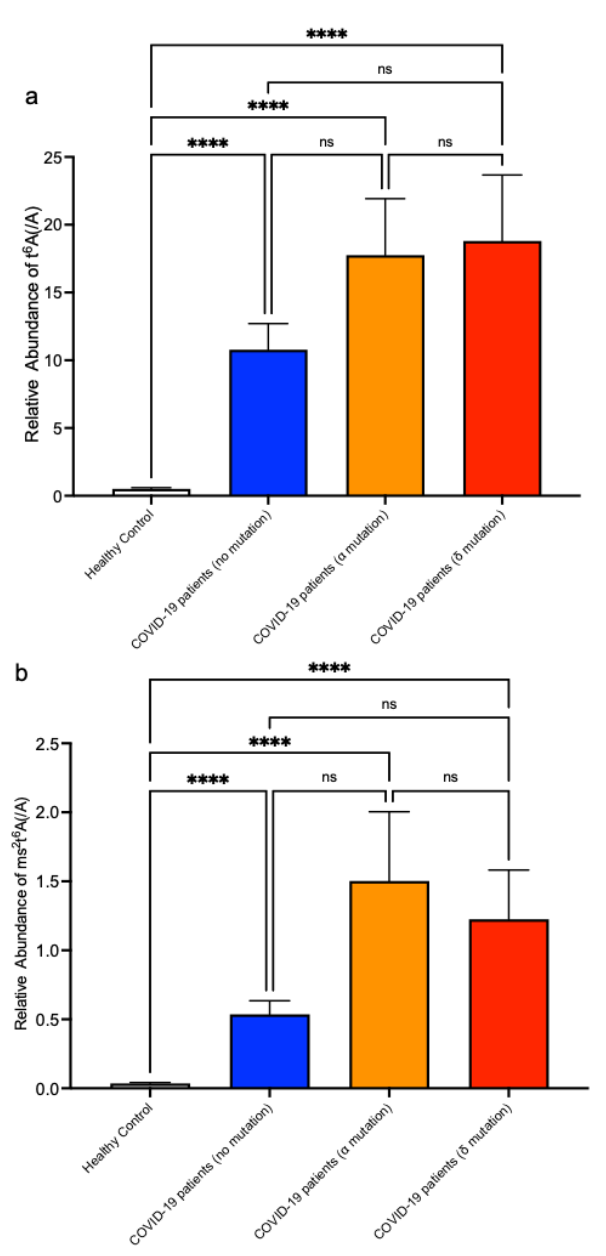
Figure 6. Elevation of t 6 A and ms 2 t 6 A levels in serum of patients infected by different SARS-CoV-2 strains. ( a , b ) Measurements of t 6 A ( a ) and ms 2 t 6 A ( b ) in serum of COVID-19 patients infected with α strain or δ strain compared with healthy volunteers. LC-MS peak areas of t 6 A or ms 2 t 6 A divided by LC-MS peak areas of adenosine are shown. **** p < 0.0001 by Kruskal–Wallis test and Dunn’s multiple comparison test. ns, not significant.